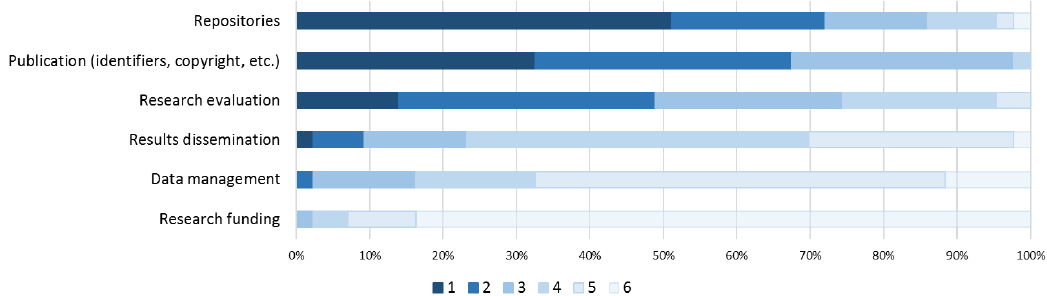
Figure 4. Ranking of research support services by library directors.